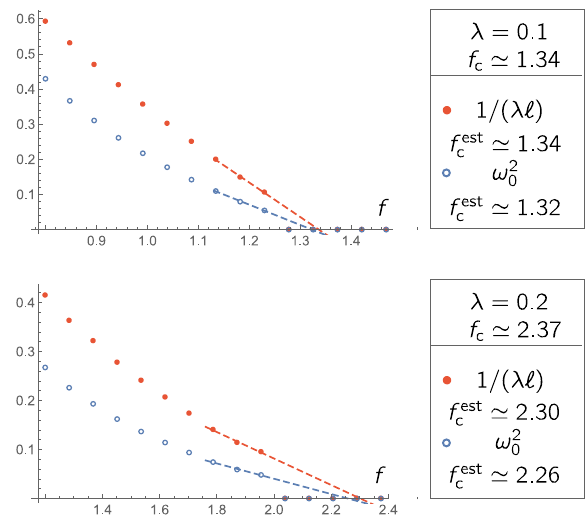
Fig. 3 Scaling behavior at the transition towards the normal state. Evolution of 1/( λ ℓ ) ( fi lled circles) and ω 2 (empty circles) close 0 to the phase transition; both quantities vanish with approximately constant slope (i.e., are ∝ f c − f ), as expected from Eqs. (19) and (21). shown in the plot legend are derived from linear Values f est c extrapolation of the last three data points (dashed lines), showing semi-quantitative agreement with f c from Eq. (17).